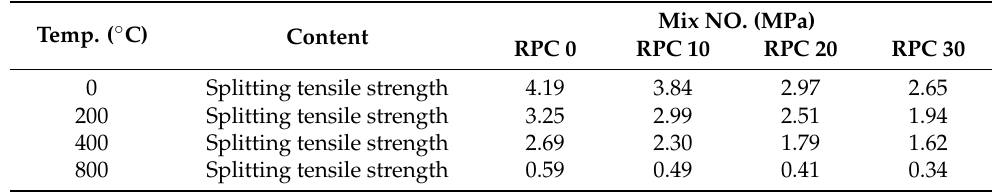
Table 6. Splitting tensile strength of rubber-concrete for high